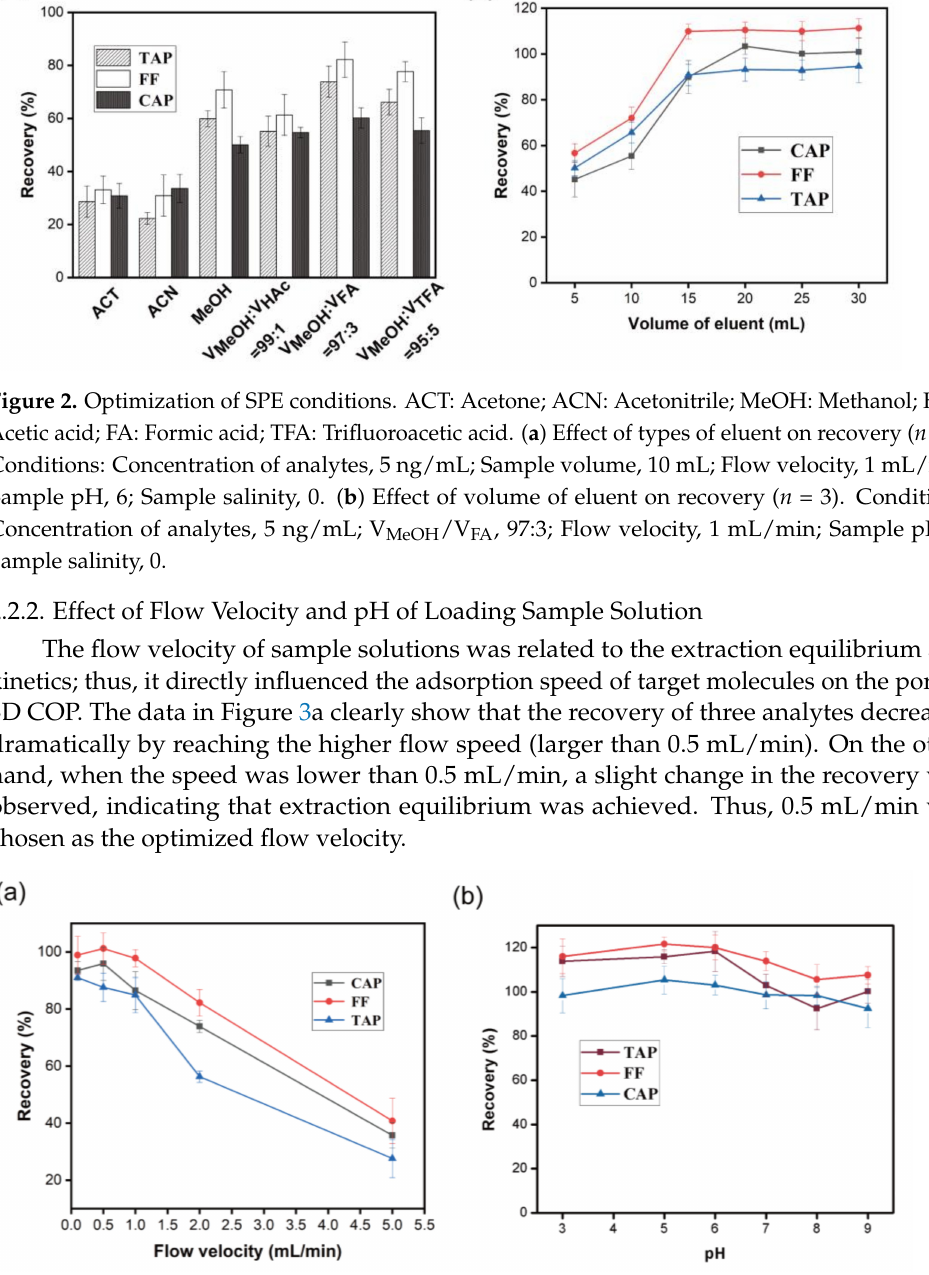
Figure 3. ( a ) Effect of flow velocity on recovery ( n = 3). Conditions: Concentration of analytes, 5 ng/mL; V MeOH /V FA , 97:3; Volume of eluent, 15 mL; Sample pH, 6; Sample salinity, 0; ( b ) Effect of pH on recovery ( n = 3). Conditions: Concentration of analytes, 5 ng/mL; V MeOH /V FA , 97:3; Volume of eluent, 15 mL; Flow velocity, 0.5 mL/min; Sample salinity,